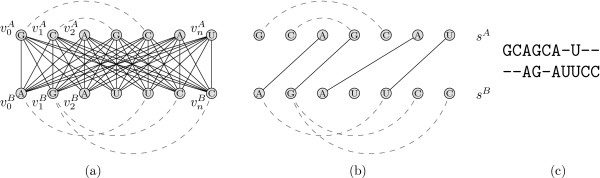
Initial graph model. (a) Initial graph model representing two annotated sequences sA = GCAGCAU and sB = AGAUUCC. Solid lines represent lines, dashed lines represent interaction edges. Please note that in this toy example minimum loop lengths constraints on the interaction edges are violated for sake of compactness of the illustration. Interactions (v1B,vn−1B
 MathType@MTEF@5@5@+=feaafiart1ev1aaatCvAUfKttLearuWrP9MDH5MBPbIqV92AaeXatLxBI9gBaebbnrfifHhDYfgasaacH8akY=wiFfYdH8Gipec8Eeeu0xXdbba9frFj0=OqFfea0dXdd9vqai=hGuQ8kuc9pgc9s8qqaq=dirpe0xb9q8qiLsFr0=vr0=vr0dc8meaabaqaciaacaGaaeqabaqabeGadaaakeaacqWG2bGDdaqhaaWcbaGaeGymaedabaGaemOqaieaaOGaeiilaWIaemODay3aa0baaSqaaiabd6gaUjabgkHiTiabigdaXaqaaiabdkeacbaaaaa@3726@) and (v1B,vnB
 MathType@MTEF@5@5@+=feaafiart1ev1aaatCvAUfKttLearuWrP9MDH5MBPbIqV92AaeXatLxBI9gBaebbnrfifHhDYfgasaacH8akY=wiFfYdH8Gipec8Eeeu0xXdbba9frFj0=OqFfea0dXdd9vqai=hGuQ8kuc9pgc9s8qqaq=dirpe0xb9q8qiLsFr0=vr0=vr0dc8meaabaqaciaacaGaaeqabaqabeGadaaakeaacqWG2bGDdaqhaaWcbaGaeGymaedabaGaemOqaieaaOGaeiilaWIaemODay3aa0baaSqaaiabd6gaUbqaaiabdkeacbaaaaa@3549@) are in conflict with each other, (v0B,vn−2B
 MathType@MTEF@5@5@+=feaafiart1ev1aaatCvAUfKttLearuWrP9MDH5MBPbIqV92AaeXatLxBI9gBaebbnrfifHhDYfgasaacH8akY=wiFfYdH8Gipec8Eeeu0xXdbba9frFj0=OqFfea0dXdd9vqai=hGuQ8kuc9pgc9s8qqaq=dirpe0xb9q8qiLsFr0=vr0=vr0dc8meaabaqaciaacaGaaeqabaqabeGadaaakeaacqWG2bGDdaqhaaWcbaGaeGimaadabaGaemOqaieaaOGaeiilaWIaemODay3aa0baaSqaaiabd6gaUjabgkHiTiabikdaYaqaaiabdkeacbaaaaa@3726@) and (v1B,vnB
 MathType@MTEF@5@5@+=feaafiart1ev1aaatCvAUfKttLearuWrP9MDH5MBPbIqV92AaeXatLxBI9gBaebbnrfifHhDYfgasaacH8akY=wiFfYdH8Gipec8Eeeu0xXdbba9frFj0=OqFfea0dXdd9vqai=hGuQ8kuc9pgc9s8qqaq=dirpe0xb9q8qiLsFr0=vr0=vr0dc8meaabaqaciaacaGaaeqabaqabeGadaaakeaacqWG2bGDdaqhaaWcbaGaeGymaedabaGaemOqaieaaOGaeiilaWIaemODay3aa0baaSqaaiabd6gaUbqaaiabdkeacbaaaaa@3549@) form a pseudoknot. Sequence sA contains only nested interactions. (b) A subset of all possible lines is shown representing the alignment (c).